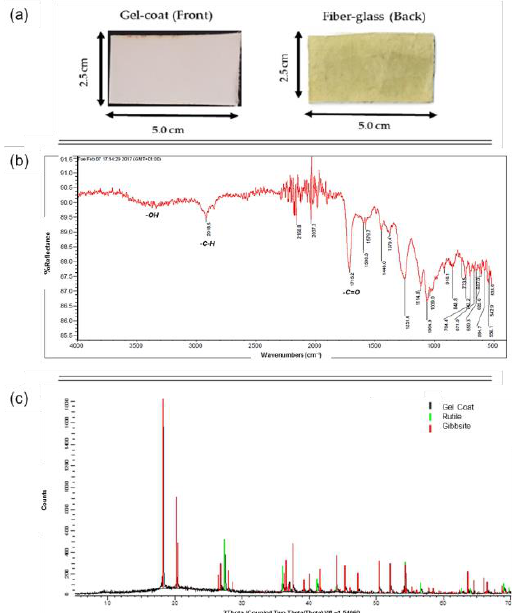
Figure 3. Substrate characterization: ( a ) front and back appearance of the original substrate; ( b ) FTIR characteristic spectrum for gel-coated surface and ( c ) XRD pattern of gel-coated surface.